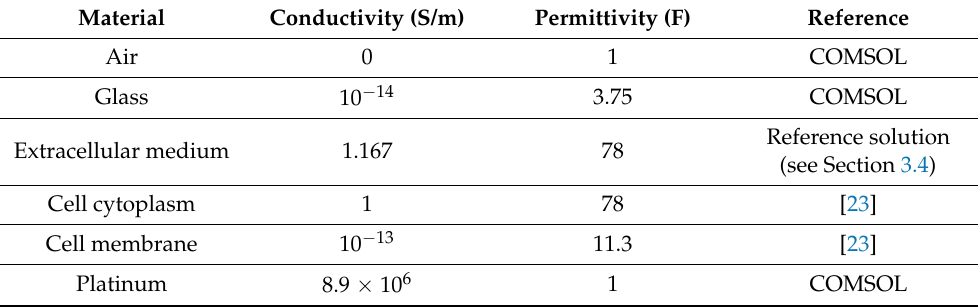
Table 1. Electrical properties used in the